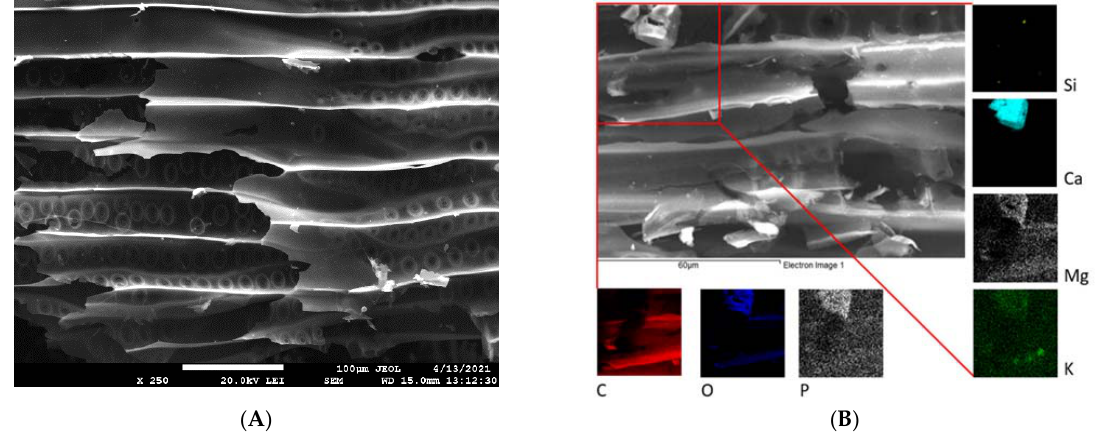
Figure 2. SEM ( A ) and EDX ( B ) images of WC biochar. EDX elemental distribution maps show elemental (C, O, P, Si, Ca, Mg, and K) composition of area closed by red lines in panel ( B ). XRD analysis was applied to determine the level of pyrolysis and identify the crys- talline structure of biochars. The X-ray diffraction patterns are shown in Figure 3, and it is clear that both CC and WC biochar exhibited broad peaks at 2 θ 23.68 ◦ (002) due to scatter- ing of X-rays by amorphous carbon (and amorphous silica) [40], and 42.97 ◦ (100), indicating the presence of aromatic carbon and formation of turbostratic crystallites [41]. Generally, sharper C (002) and C (100) peaks indicate a higher degree of crystalline orientation of C in biochar samples [42]. Biochar produced from wood chips at 500 ◦ C consisted of several other crystallite phases such as calcite (CaCO 3 ) and quartz (SiO 2 ). In contrast, corn-cob biochar was more strongly associated with the presence of sylvite (KCl) and quartz (SiO 2 ), and only very slightly with calcite (CaCO 3 ), and other mineral impurities. The higher carbonate content of WC biochar is probably related to the presence of calcium oxalate (CaO x ) crystals in the leaves, wood, and bark of many plants, which transform to calcite at pyrolysis temperatures above 500 ◦ C [43]. Moreover, the formation of calcite contributes to the alkalinity of the prepared CC and WC biochars, as shown by their relatively higher pH values (Table 2).